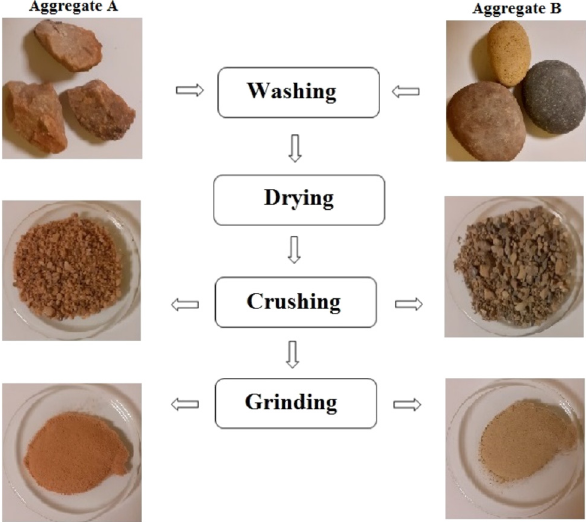
Figure 1: Photographs and the preparation setup of the aggregates A and B.